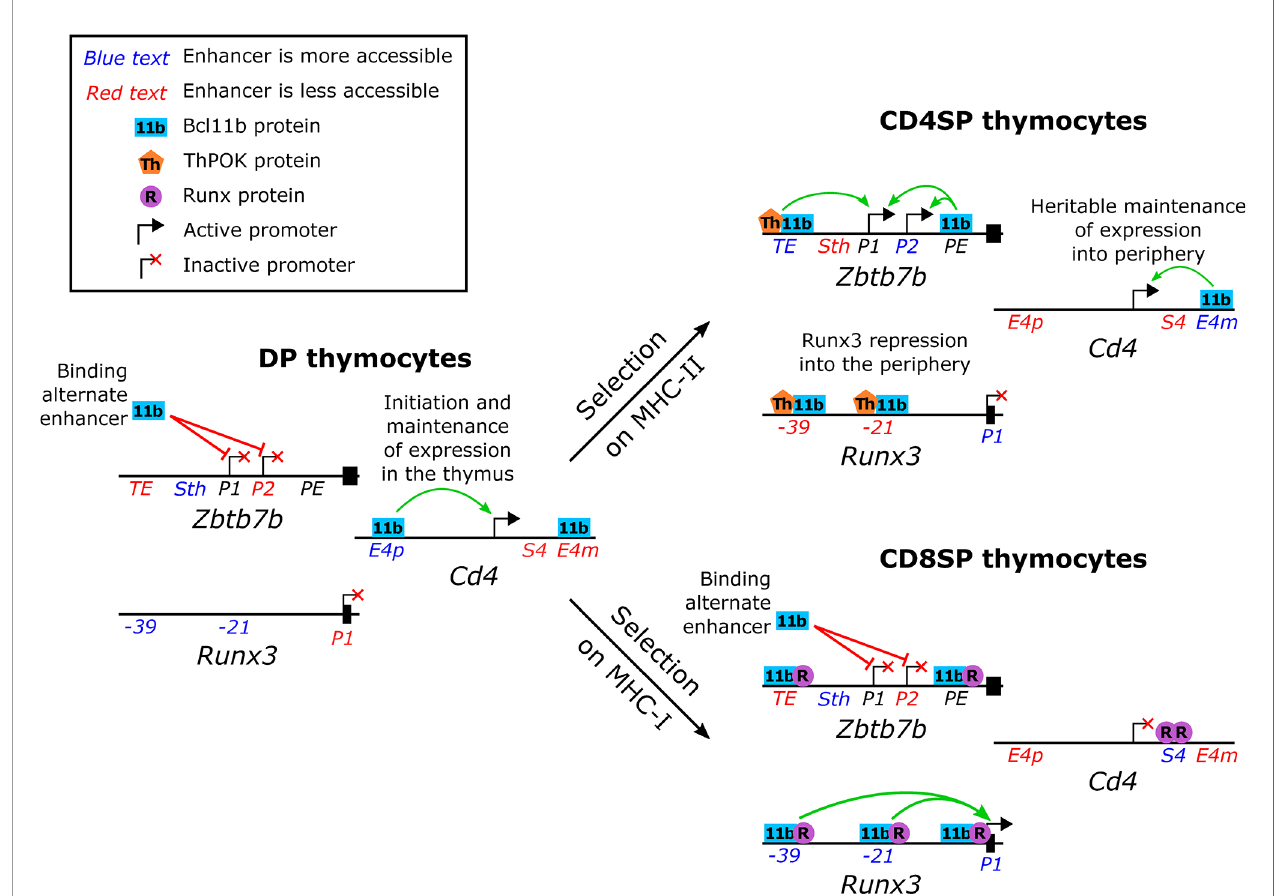
FIGURE 4 | Normal functions of Bcl11b in single positive thymocyte lineage commitment. Schematic representation (not to scale) of the upstream regions of the Zbtb7b (ThPOK), Runx3 and Cd4 loci in pre-positive selection double positive and in single positive thymocytes. Enhancers that show a dynamic difference in accessibility are indicated in either blue (more accessible than in the comparator thymocyte subsets) or red (less accessible than in the comparator thymocyte subsets) as determined by chromatin modi fi cations [ Cd4 enhancers (36)] or ATAC-seq [ Zbtb7b and Runx3 enhancers (2)]. Green and red arrows indicate supportive and inhibitory roles, respectively, of Bcl11b in